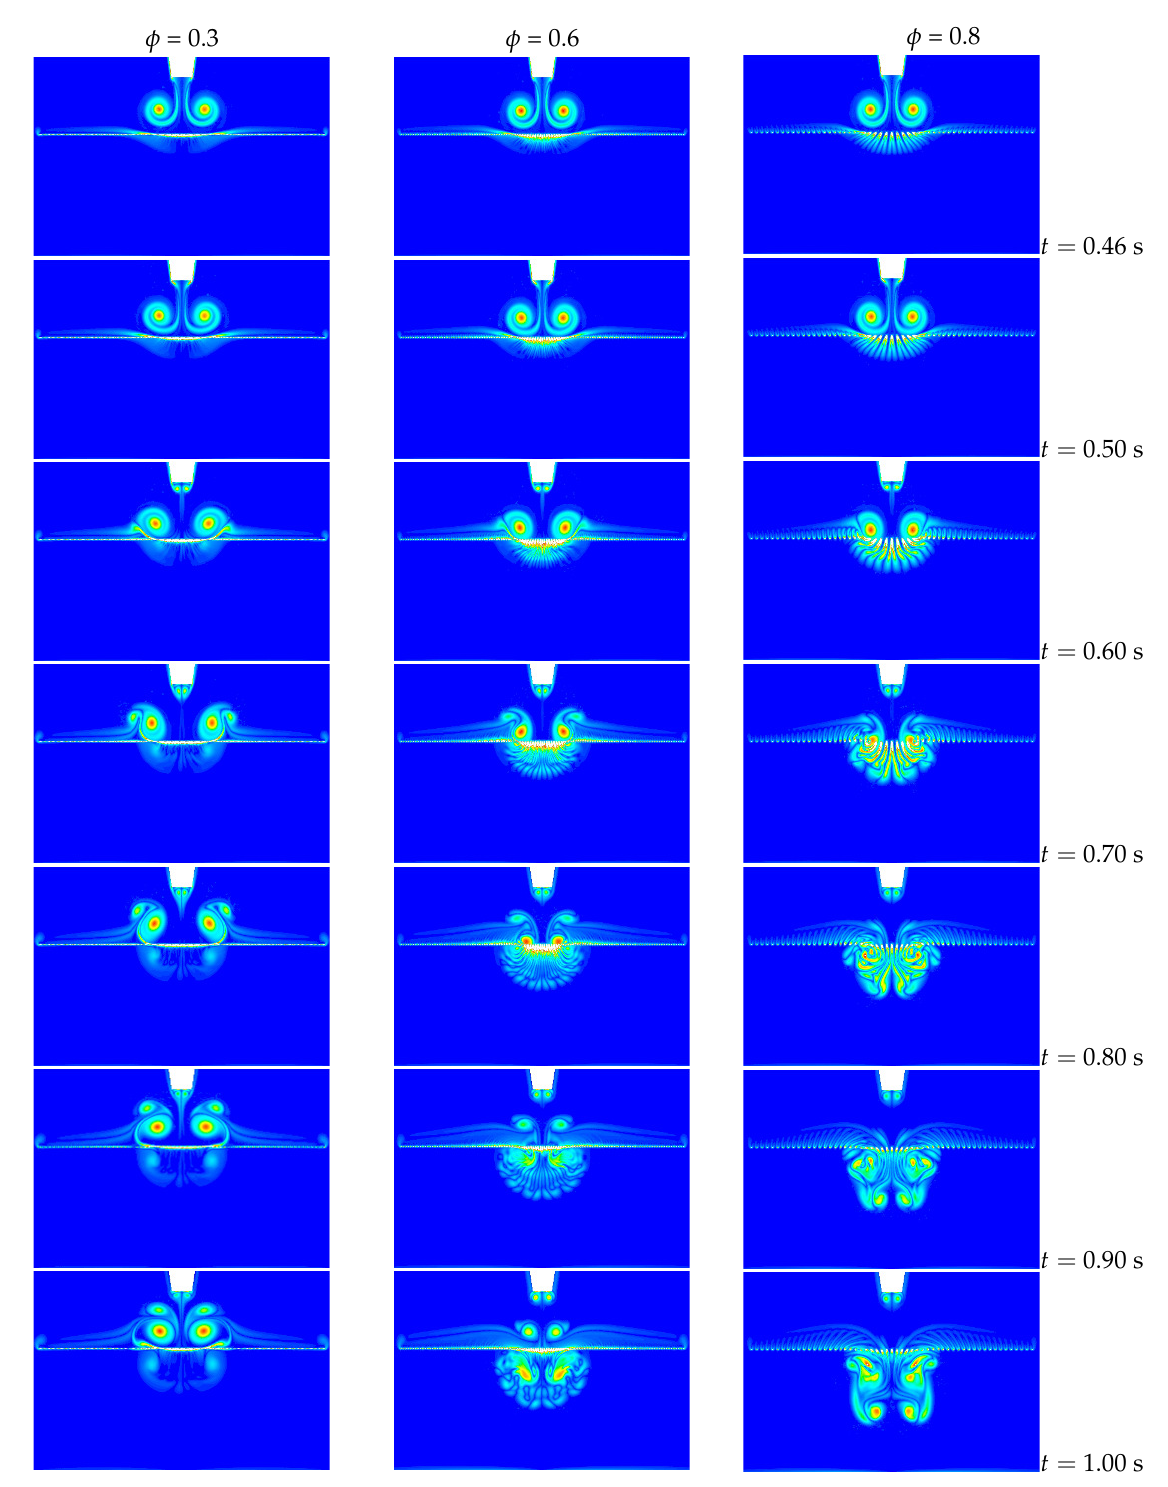
Figure 10. Vortex ring evolution at Re = 1800. From t = 0.80 s to t = 1.00 s, for the fine mesh case, both primary and secondary vortex rings are still rotating upon the porous screen. A small amount of air transmits across the surface and forms a weak vortex structure. For the medium mesh case, the primary vortex ring fully passes across and forms a new vortex structure below the porous screen. The secondary vortex ring shrinks and moves close to the surface. For the coarse mesh case, the primary vortex ring is disrupted by the screen rod and partially reforms